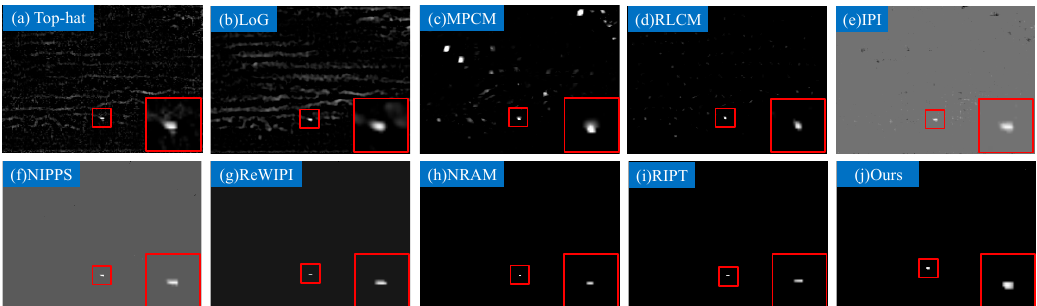
Figure 15. Results of the different approaches to Sequence 1.